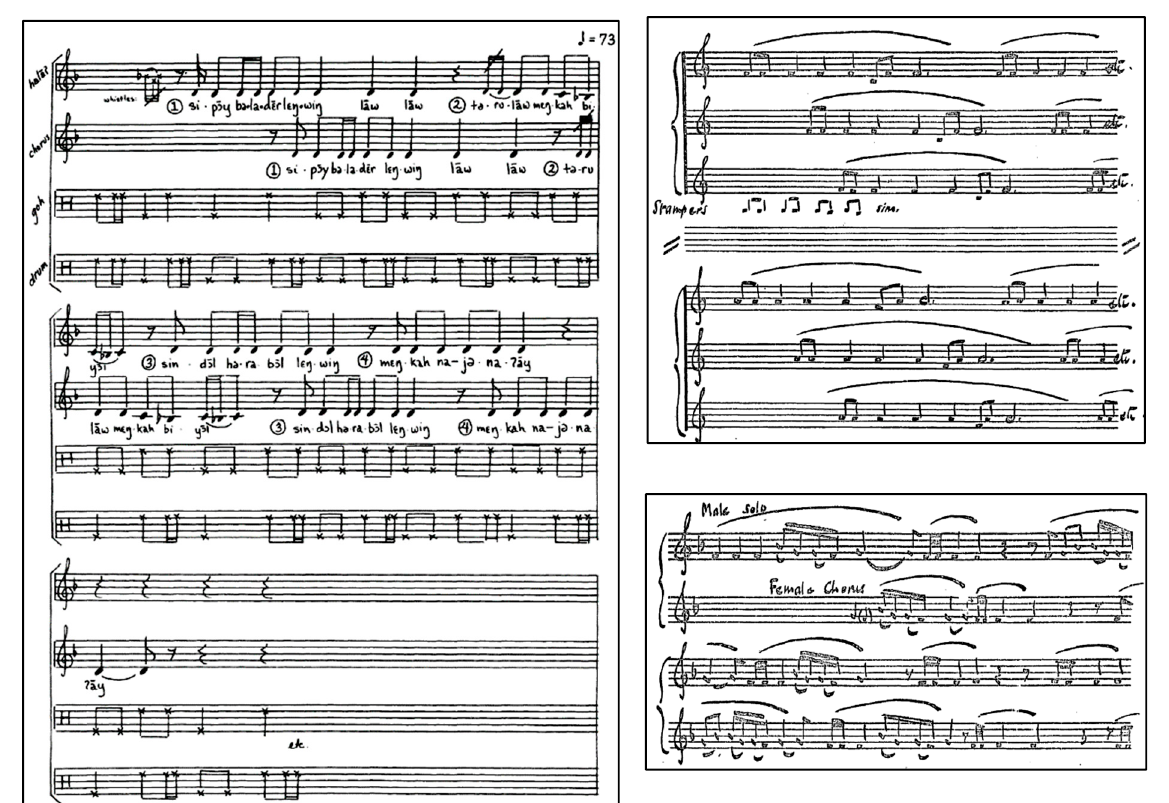
Figure 2. Transcriptions of Temiar canonic overlap. ( Left ) From a Temiar song performance by Abilem Lum, as recorded and transcribed by Marina Roseman (1984, p. 423). Hal ā ˀ is the lead singer, goh [properly g ɔɔ h ] are the chorus’s bamboo-tube beaters. ( Right ) Portions of Temiar songs (1962) from Kuala Kenrap, Kelantan, as recorded and transcribed by Jack Dobbs (1972, pp. 39–40). (cid:108)(cid:108)